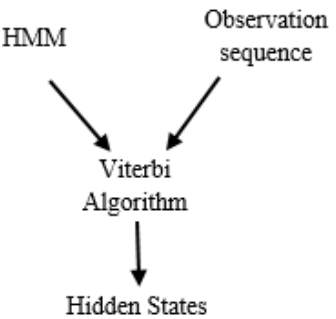
Figure 21. Schematic of hidden Markov model (HMM), Viterbi algorithm, observations and states.